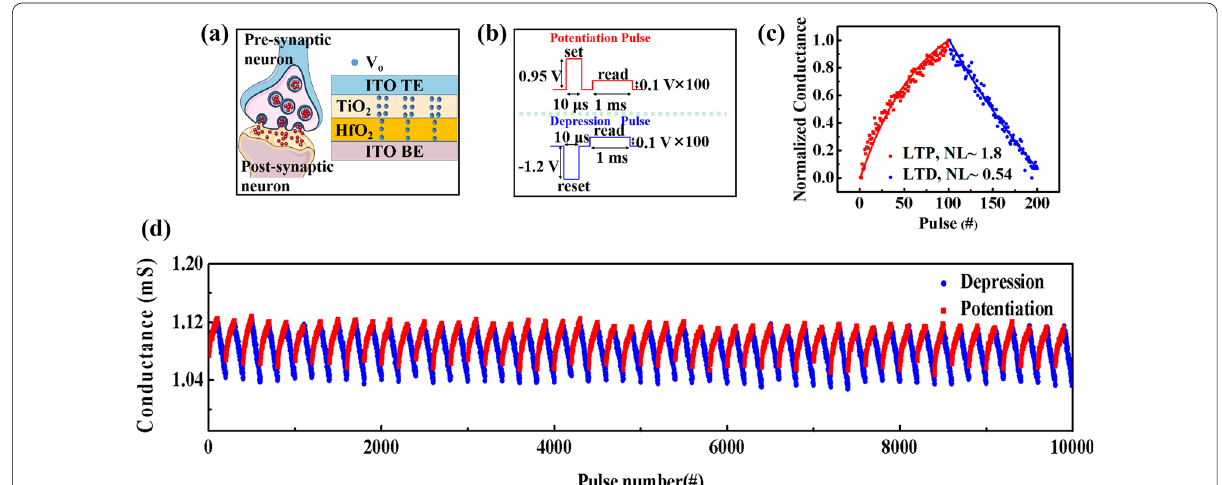
Fig. 3 a Schematic diagram of the synapse and the structure of the ITO/HfO 2 /TiO 2 /ITO synaptic device. b Pulsing schemes for potentiation and depression, respectively. c Gradual conductance modulation of potentiation and depression under successive pulse stimulation. d Stable 50 epoch potentiation and depression